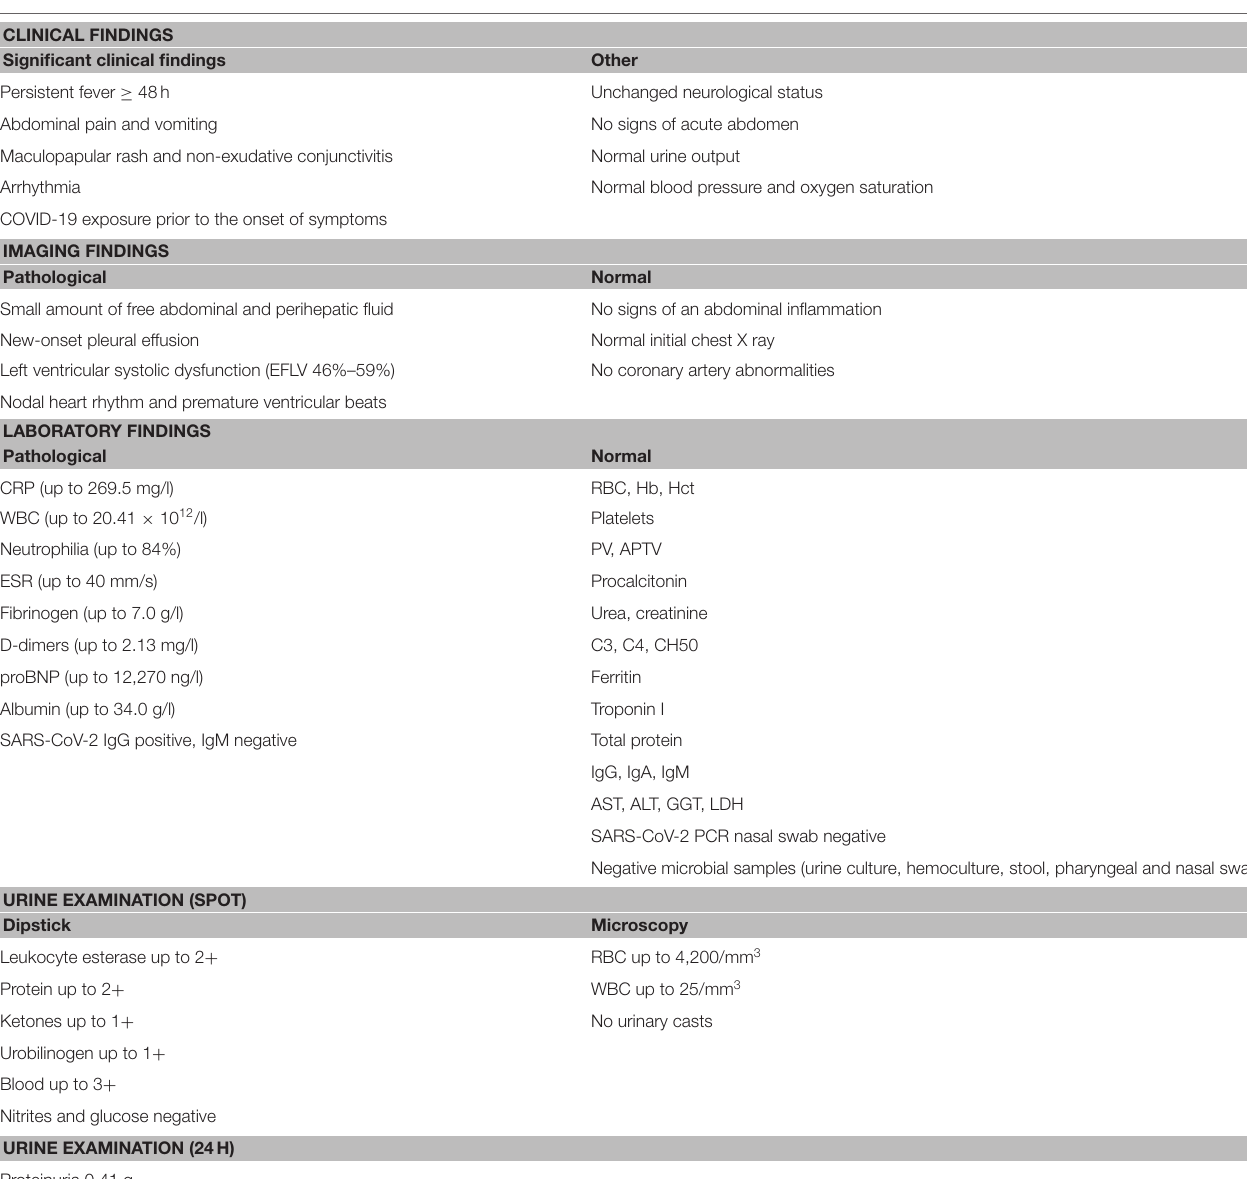
TABLE 2 | Clinical, laboratory and imaging